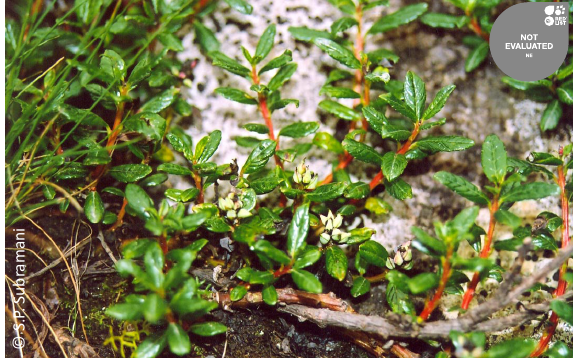
Image 21. Cypripedium cordigerum D. Don